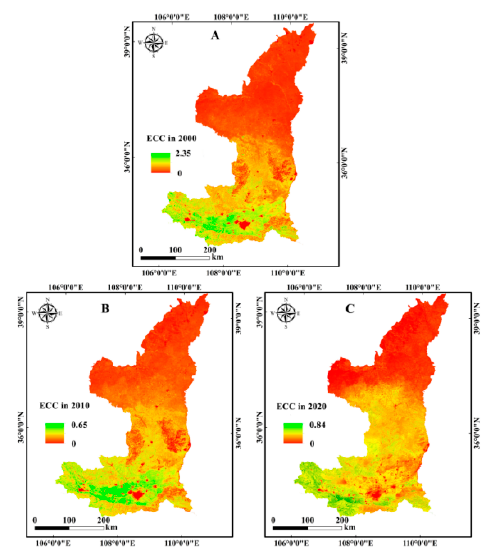
Figure 5. ECC in the YRBS from 2000 to 2020 (raster mean). ( A ) 2000, ( B ) 2010, and ( C ) 2020. Unit: Basin hectare (wha).